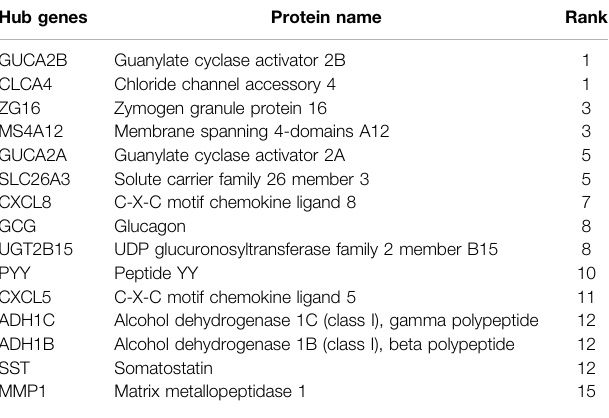
TABLE 5 | The hub genes with top15 ranking of the PPI network. Hub